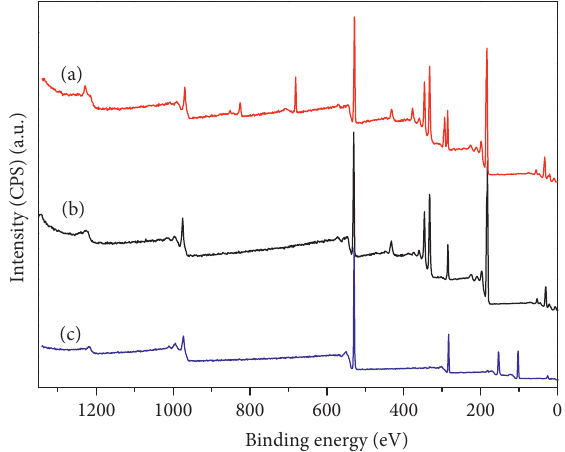
Figure 5: XPS profiles of (a) 5wt.% KF/ZrO 5wt.% KF/ZrO 2 (after recycling 5